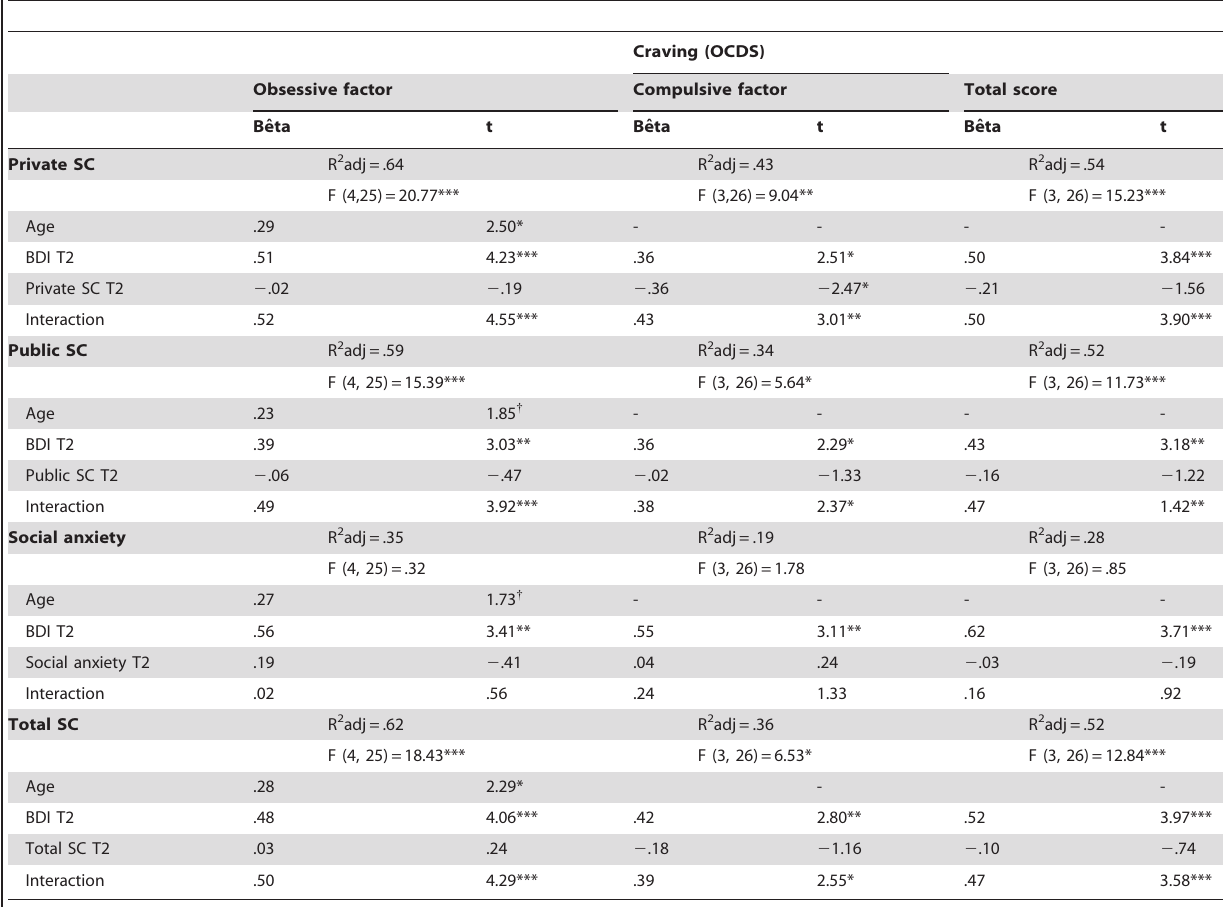
Table 3. Multiple regression analyses predicting craving scores (T2) as a function of depression T2, SC T2, and their